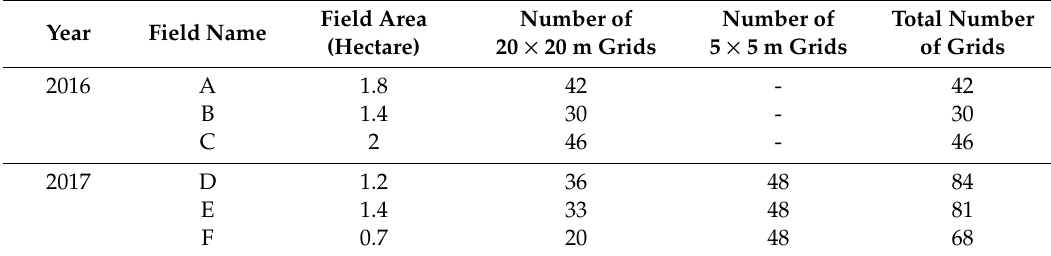
Table 1. Characteristics of the fields in this